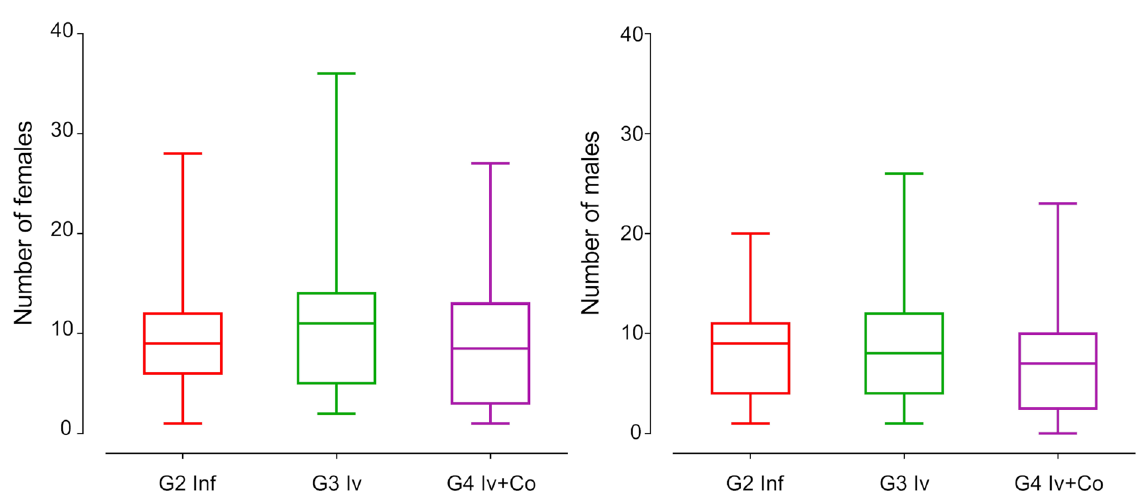
Figure 3. Male and female worm recovery in the necropsy eight weeks post-infection of mice treated with ivermectin (Iv) or ivermectin and cobicistat (Iv + Co), infected with 150 cercariae of S. mansoni